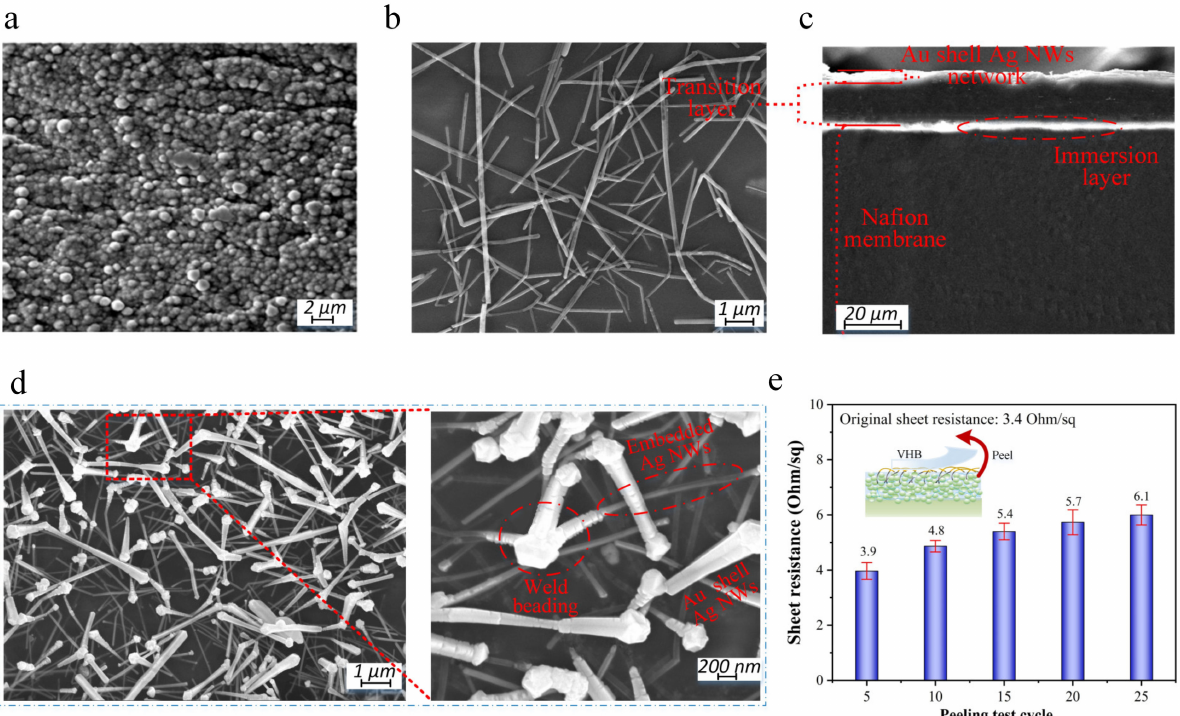
Figure 2. Characterization of different samples. ( a ) Micromorphology of Pd-based IPMC. ( b ) Micro- morphology of Ag-NW-based IPMC. ( c ) Cross-section of Au-shell-Ag-NW-based IPMC. ( d ) Micro- morphology of Au-shell-Ag-NW-based IPMC. ( e ) Peeling test